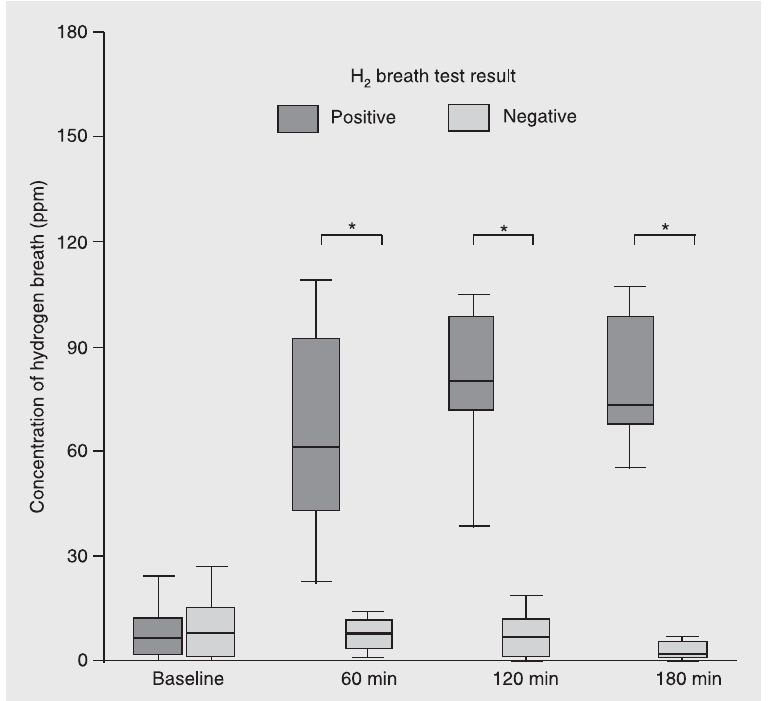
Figure 1. Results of the hydrogen breath test (HBT) in subjects with (positive HBT) and without lactose malabsorption (negative HBT). Results are presented as median and 25- 75% quartiles. *P < 0.001, HBT level of subjects with malabsorption compared with subjects without malabsorption (Mann-Whitney test).